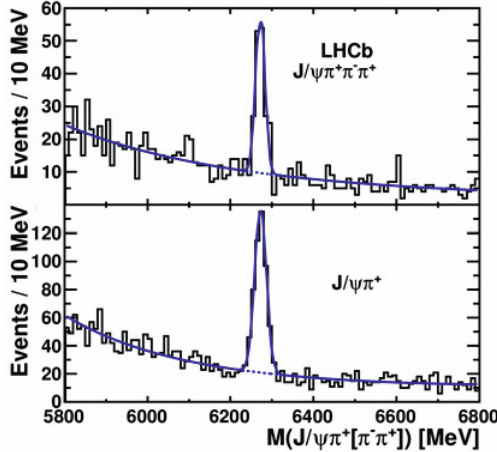
Figure 4. Invariant mass distribution of B + c → J /ψπ + π − π + (top) and B + c → J /ψπ + (bottom) candidates. nant contribution is from B + c → J /ψ a +